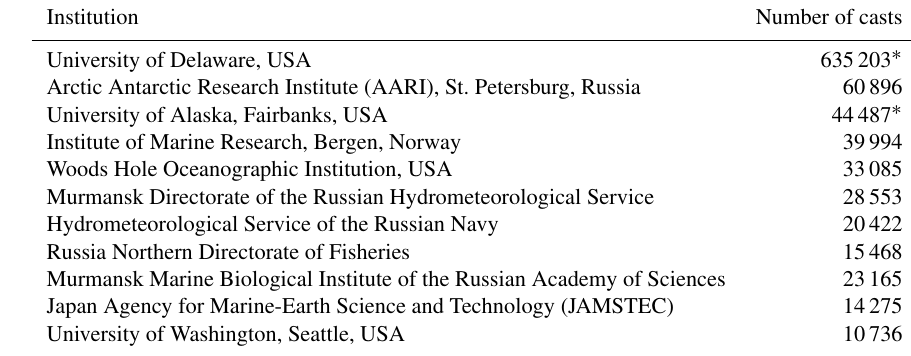
Table 3. Institutions submitting the most casts from the Arctic Ocean to WOD, and number of casts